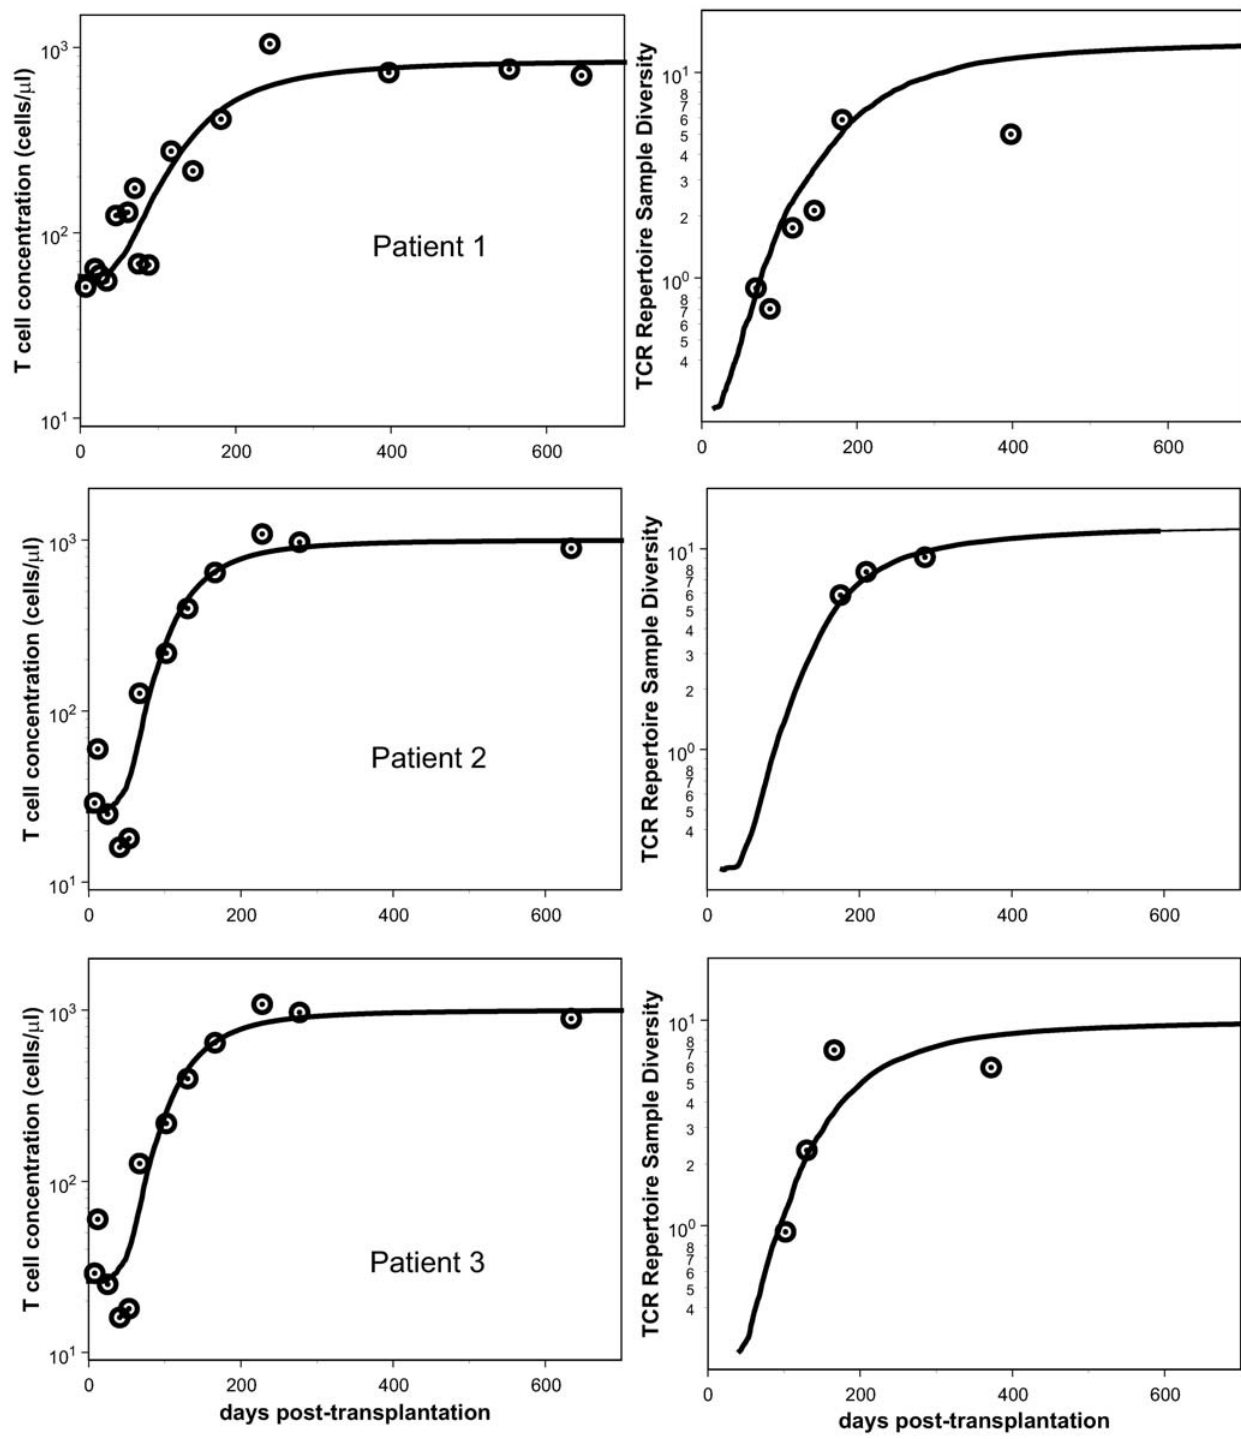
Figure 3. Best fit to the data. Maximum-likelihood fits of the population-dynamic model given by Eqs.(1,4) to patient data. The curves are the trajectories of c 0 z h T and D , respectively.